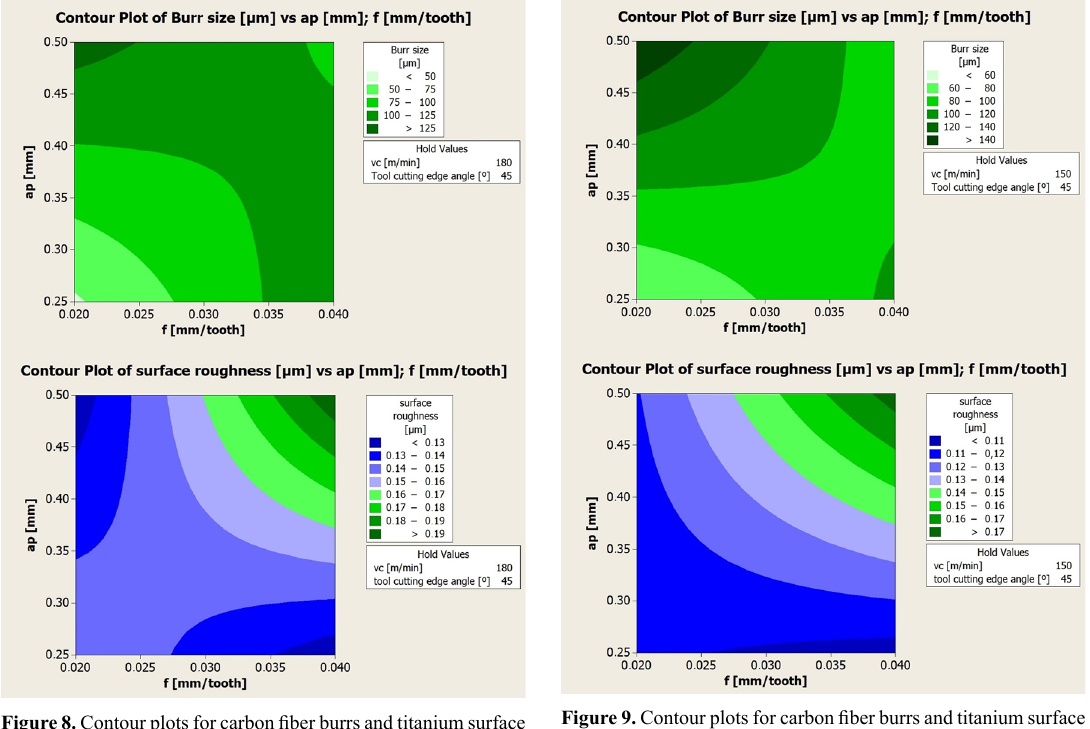
Figure 8. Contour plots for carbon fiber burrs and titanium surface roughness, (vc = 180 m/min)